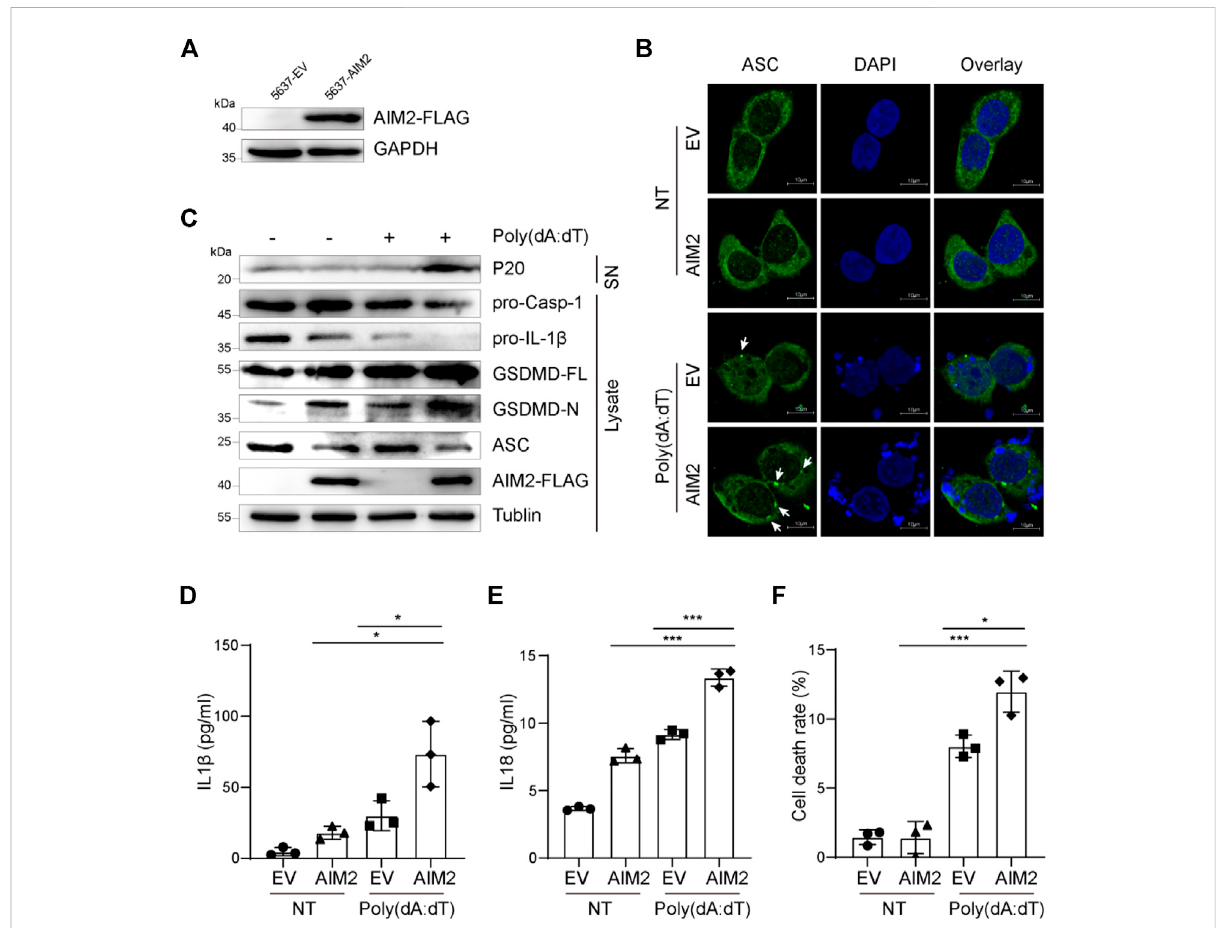
FIGURE 3 AIM2-overexpressionin5637cellsenhancedin fl ammasomeactivation. (A) Immunoblottingshowingproteinlevelof fl ag-taggedAIM2inAIM2- overexpressed 5637 cells and the control. (B) Immuno fl uorescence images of AIM2-overexpressed 5637 cells and the control after transfected with or without poly (dA:dT) for 3 h. White arrows indicate the ASC specks. (C) Immunoblot analysis of p20 in the supernatants (SN), and pro-caspase-1, pro-IL-1 β , and GSDMD in the lysates of poly (dA:dT)- treated 5637 cells. (D) ELISA of IL-1 β in the supernatants of 5637 cells after poly (dA:dT) stimulation. (E) ELISA of IL-18 in the supernatants of 5637 cells after poly (dA:dT) stimulation. (F) Lactate Dehydrogenase (LDH) release in the supernatantsofpoly(dA:dT)stimulated5637cells,detectedbydiaphorasecatalyzediodonitrotetrazoliumchloride(INT)colorreaction.In (D – F) ,the cellsweretreatedwithpoly(dA:dT)(1 μ g/ml,9 h)ornot.Datain (D – F) arepresentedasthemeans±SEM. p -valuesin (D – F)